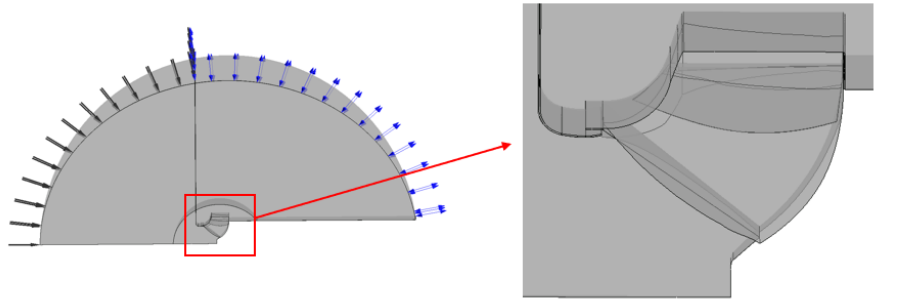
Figure 7. CFD model in ANSYS CFX.